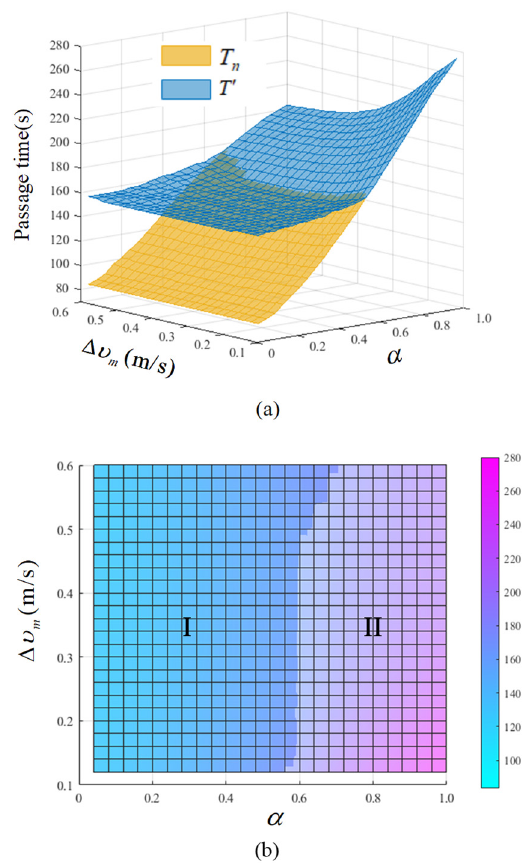
Figure 6. Variation trend of travel time. ( a ) Three-dimensional figures; ( b ) two-dimensional fig- ures.